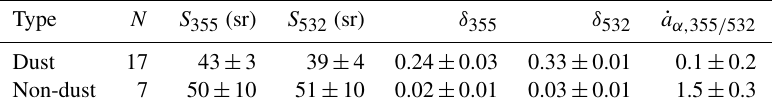
Table 2. Mean values ± SD of pure dust and non-dust lidar ratios ( S 355 , S 532 ), particle linear depolarization ratios ( δ 355 , δ 532 ) at 355 and 532nm wavelength and extinction-related Ångström exponent ( ˙ a α, 355 / 532 ). N is the number of cases.